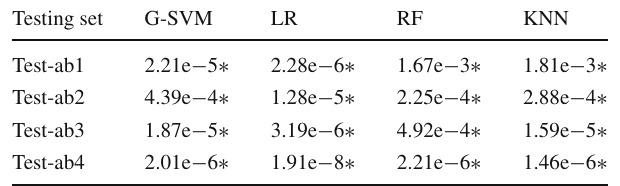
Table 11 Acc of FT-IMF all on all five classifiers Testing set